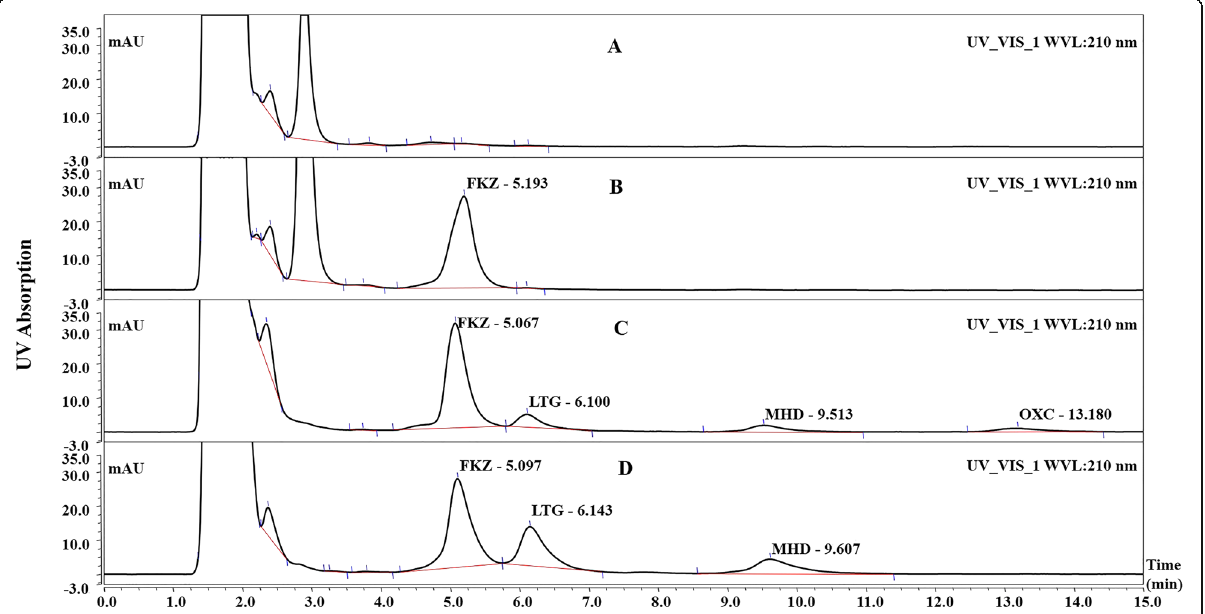
Fig. 1 Typical chromatogram of lamotrigine (LTG), 10,11-dihydro-10-hydroxycarbazepine (MHD), oxcarbazepine (OXC), and internal standard (fluconazole) obtained from: a blank plasma, b blank plasma only spiked with internal standard (fluconazole), c lowest limit of quantitation (2.4 mg/L for LTG, MHD, and OXC), d sample from a